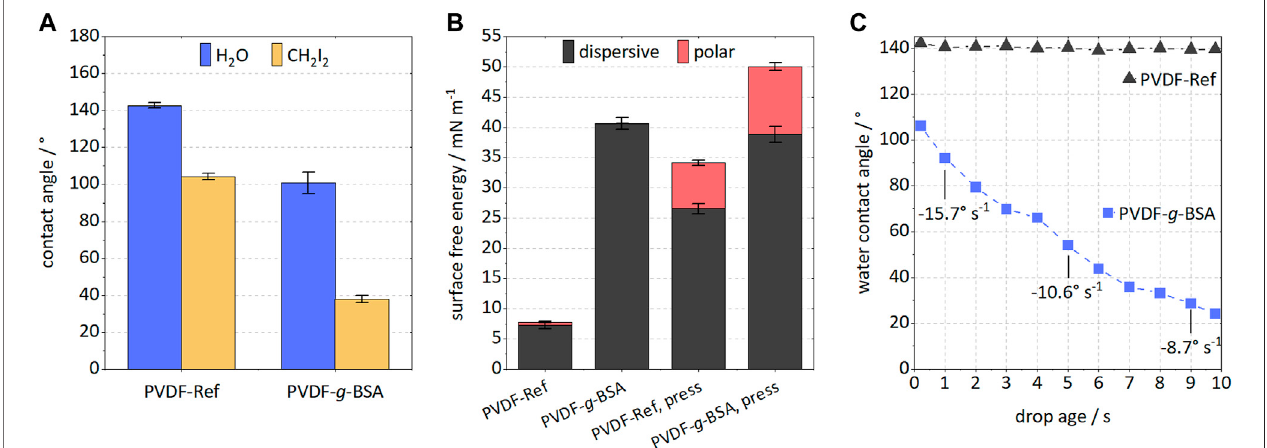
FIGURE 5 | Investigation of membrane surface hydrophilicity for PVDF-Ref and PVDF- g -BSA (optimized 1-step method). (A) contact angle measurement using waterand CH 2 I 2 ; (B) surfacefreeenergywithpolar and dispersive components forraw and pressed samples;and (C) dynamicattenuation curve ofwatercontact angle with drop age for BSA-grafted sample (given are three decay rates of contact angle referred to the initial value). Please note, the reference showed no change in contact angle within 10